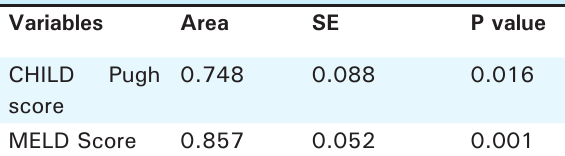
Table 4. Receiver Operator Curve (ROC) for predicting accuracy of